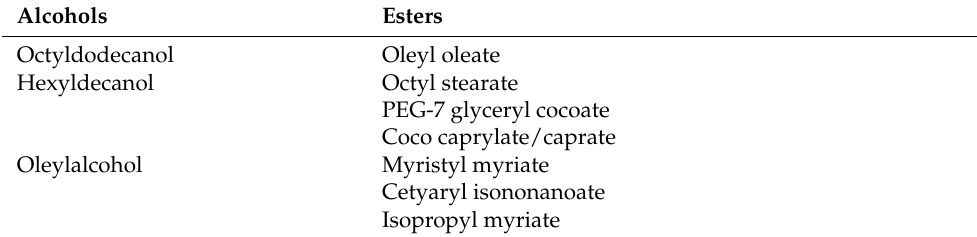
Table 1. Emollient